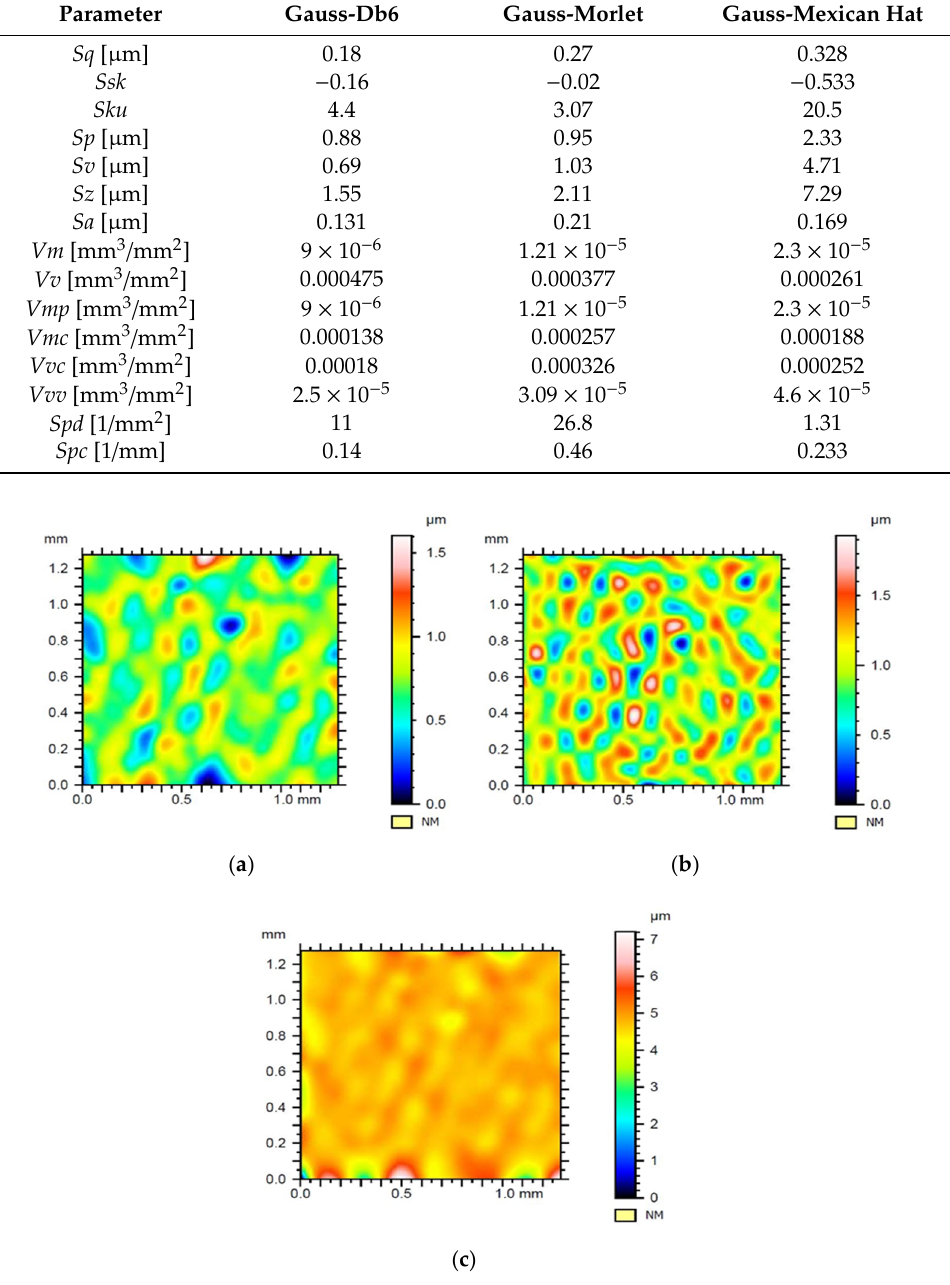
Figure 19. Surfaces created as a result of subtracting the structure obtained with wavelet from the structure after using Gaussian filtering: ( a ) Daubechies wavelet, ( b ) Morlet wavelet, ( c ) Mexican hat wavelet. The root mean square error: ( a ) 0.18 μm, ( b ) 0.27 μm, ( c ) 0.31 μm .